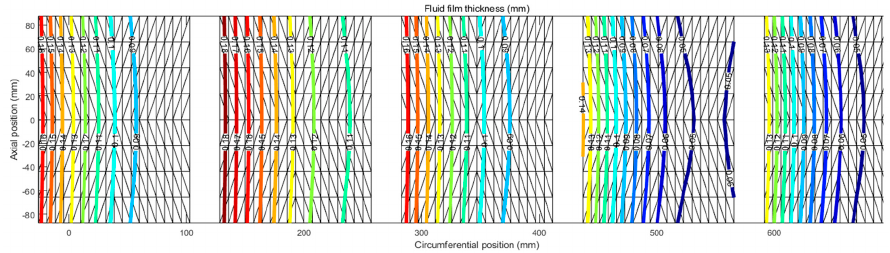
Figure 10. Film thickness distribution on pad.